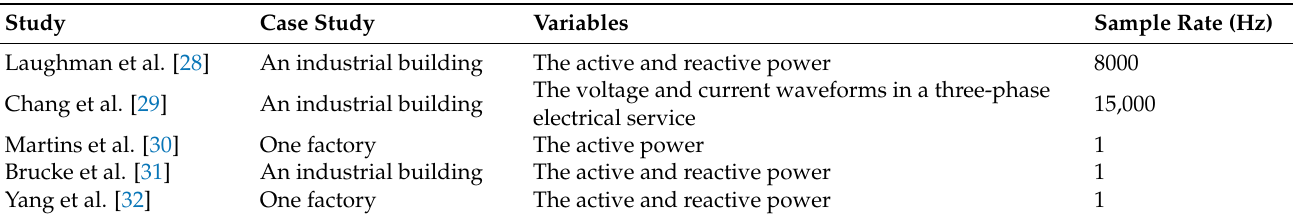
Table 1. Industrial load disaggregation